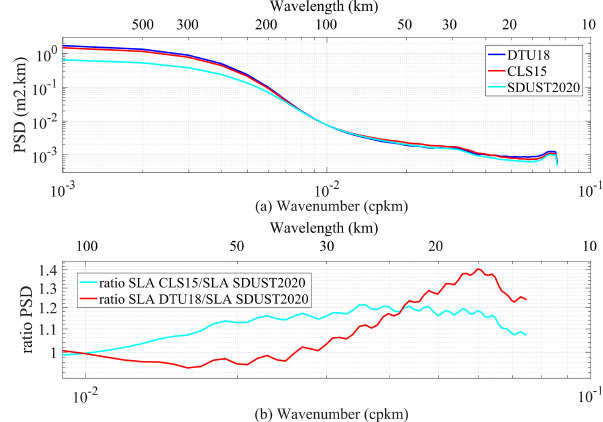
Figure 13. (a) The SLA PSD along Sentinel-3B tracks using sev- eral models. (b) The ratio of SLA PSD from panel (a)